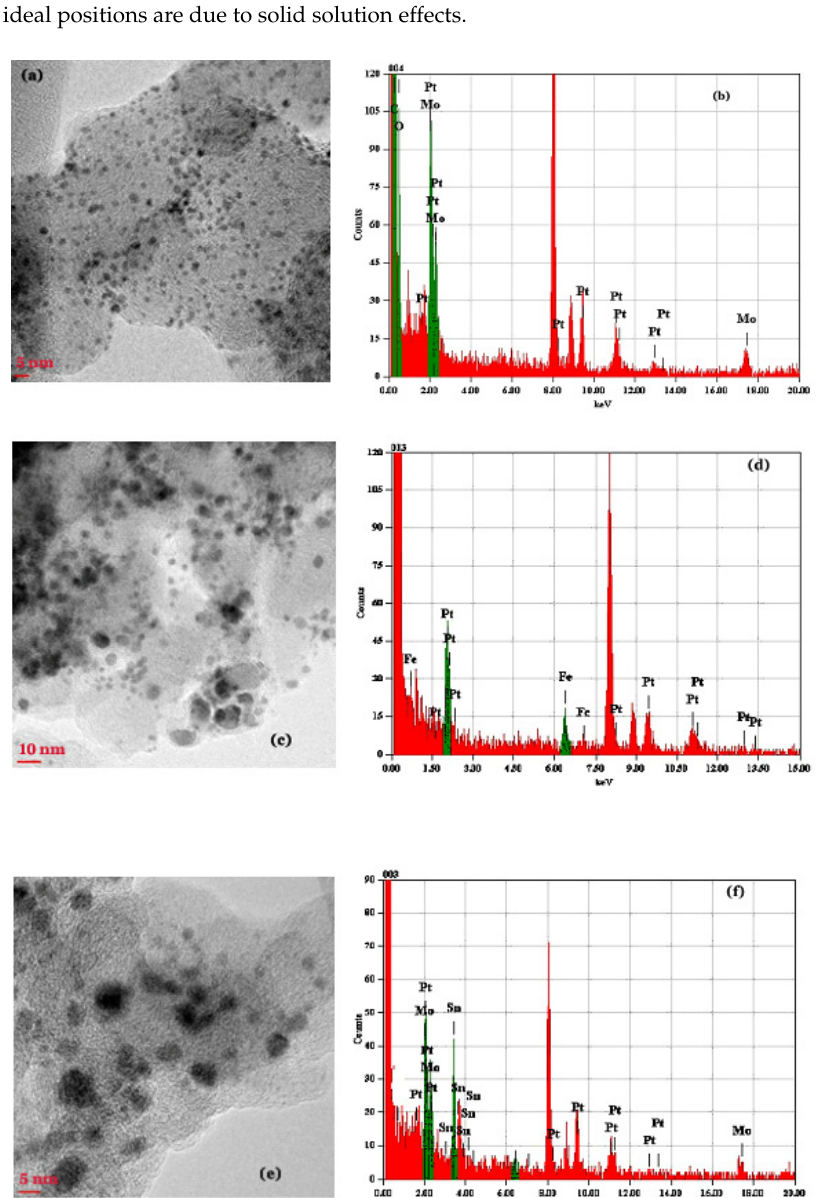
Figure 1. XRD patterns of the PtMo/C (1), PtFe/C (2) and PtMoSn/C (3) catalysts. Symbols mark positions of main reflections of principal phases (Pt, PtFe, PtSn) with corresponding numbers of International Center for Diffraction Data (ICDD) cards. Small shifts of the observed peaks from the ideal positions are due to solid solution effects.